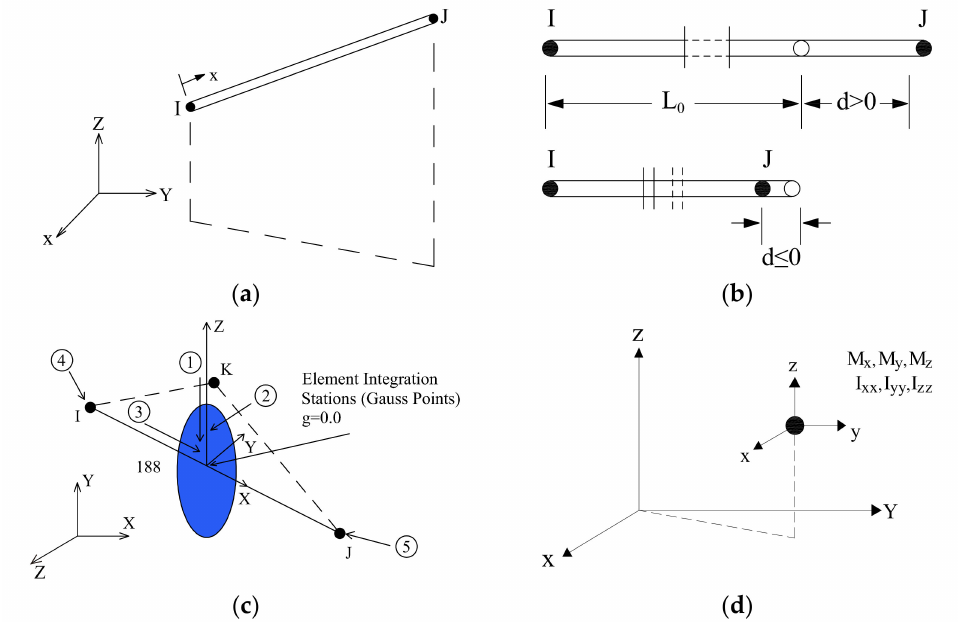
Figure 13. Element types used in the numerical simulation. ( a ) 3D two-node tension-compression element, LINK8; ( b ) 3D two-node cable element, LINK10; ( c ) 3D two-node beam element, BEAM188; ( d ) Single-node, concentrated mass element,